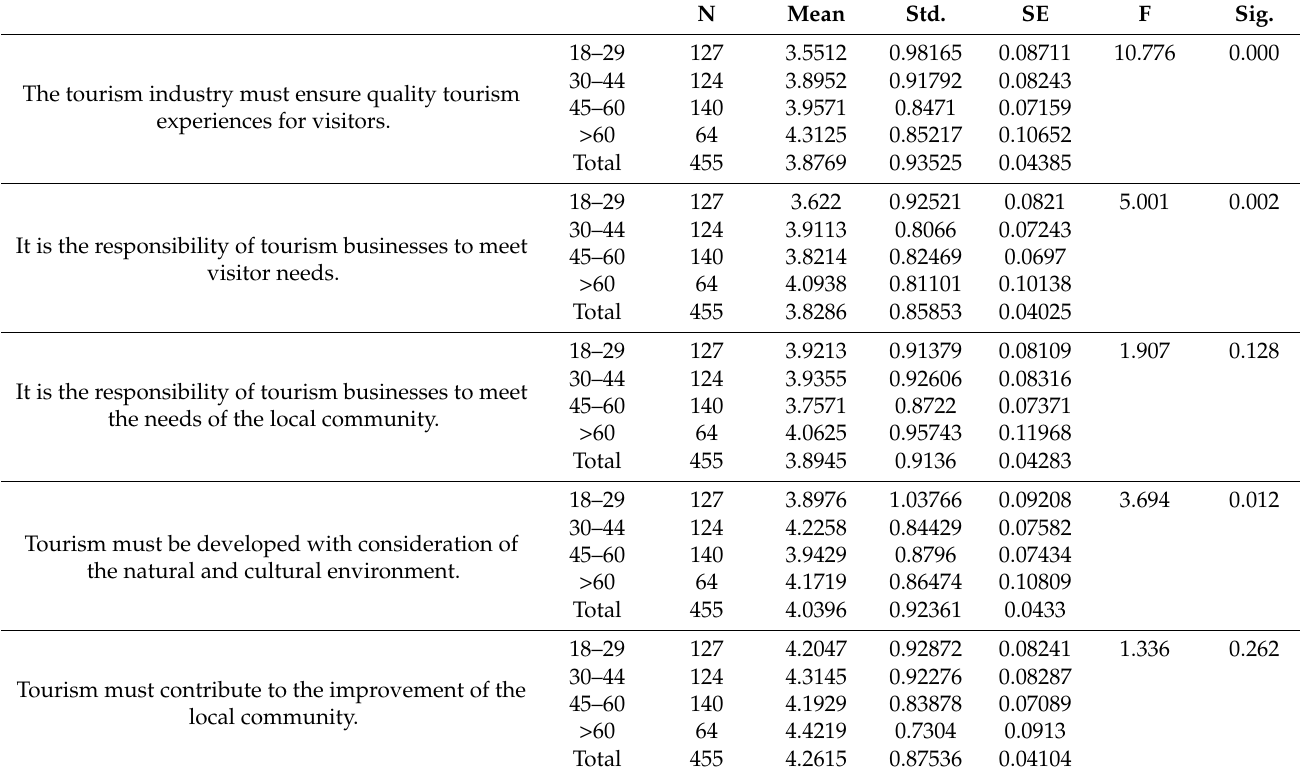
Table 6. Participants’ view of the responsibilities of the tourism industry, by age. N Mean Std. F